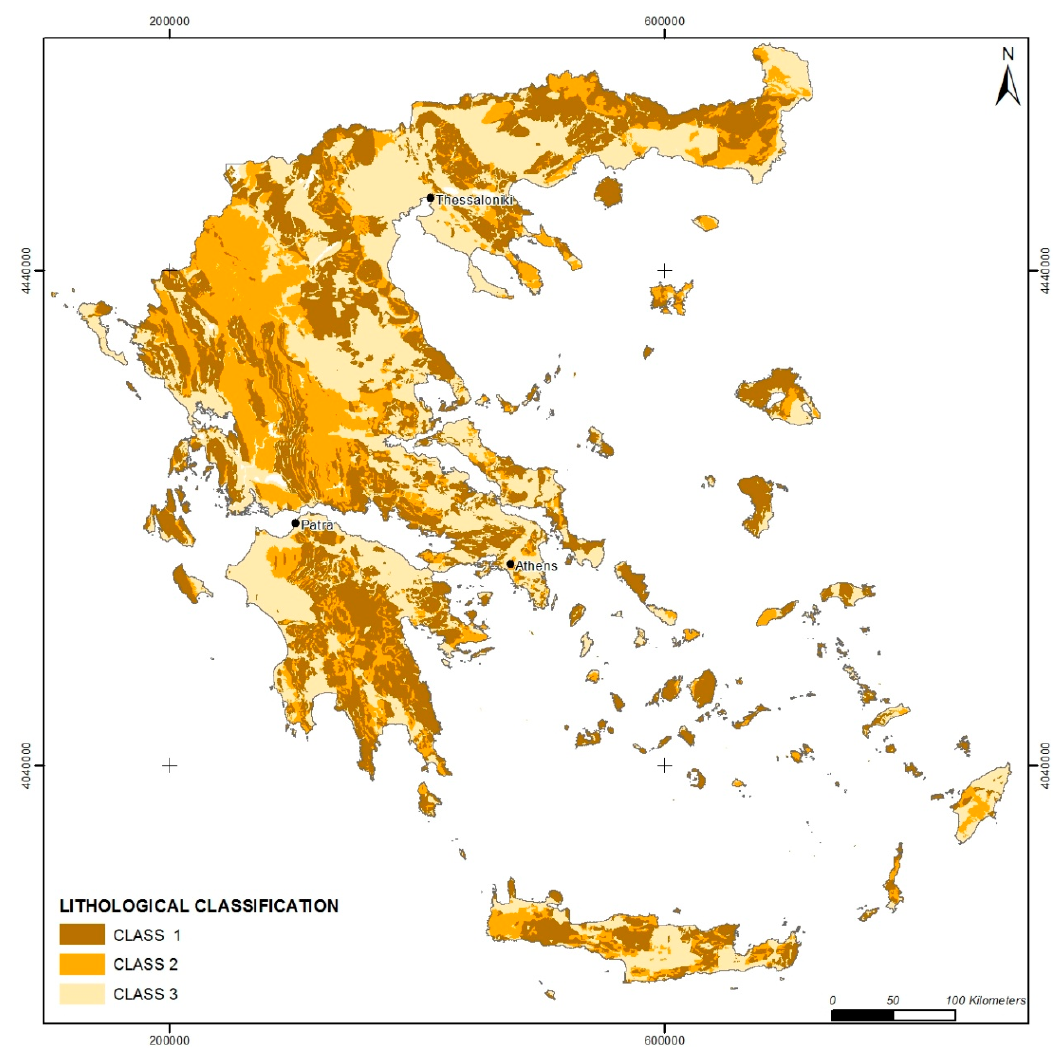
Figure 8. Thematic map of classification of lithology in Greece.